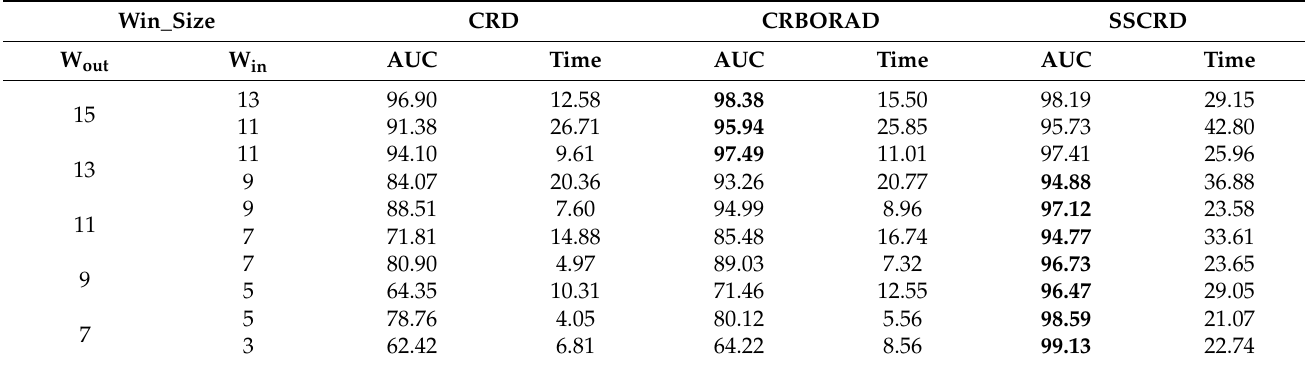
Table 1. AUC values (in %) and computing times (in seconds) for San Diego-I